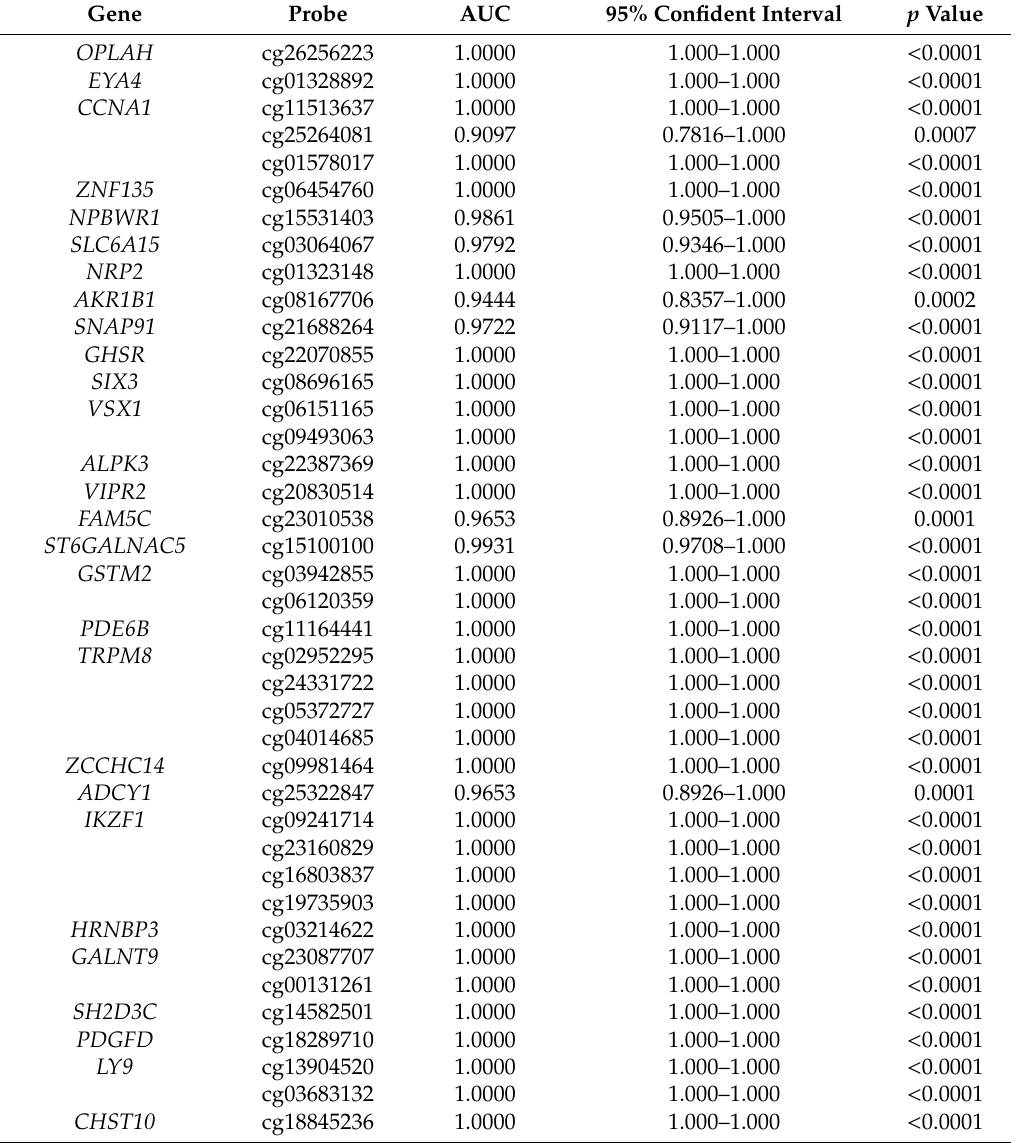
Table 2. Receiver operating characteristics (ROC) curve analysis of the di ff erentially methylated probes in open